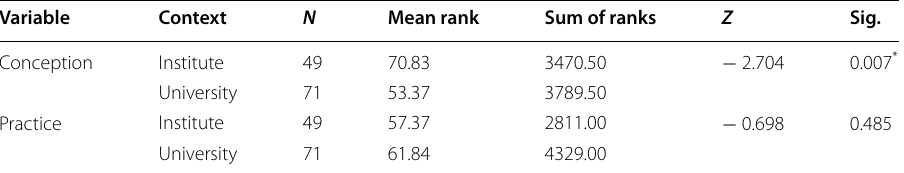
Table 7 Mann‑Whitney test for teaching context